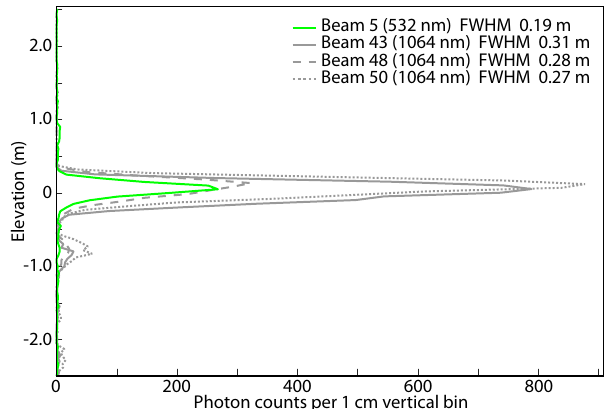
Figure 4. Histograms of the signal return for the MABEL beams used in this analysis (5, 43, 48, and 50). Plotted are ocean surface- return photon counts (per 0.01m vertical bins) over a 3km along- track distance against elevation (m). The elevations are calibrated to one another and detrended. The full width at half maximum (FWHM) for each histogram is indicated in the legend. The sec- ondary return 0.75m below the main signal return, which is more evident in the 1064nm beams, is due to unintended secondary pulses from the MABEL laser that occur under some operational conditions; this was removed for FWHM analysis.